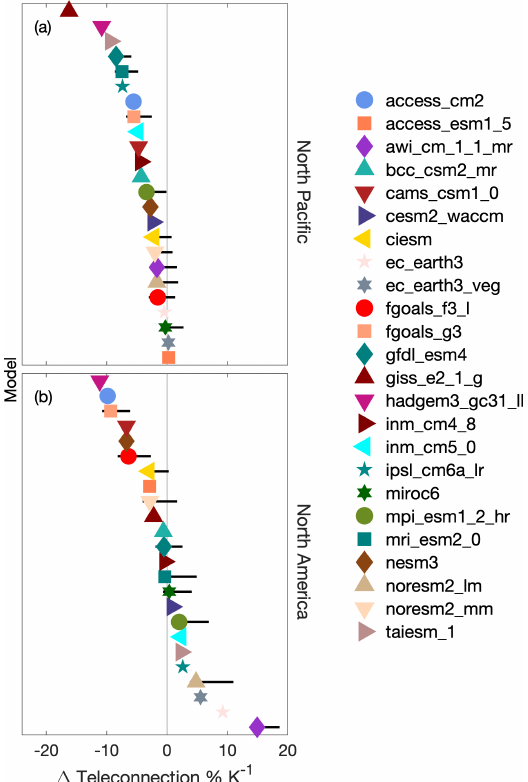
Figure 8. The total change to the MJO teleconnection over (a) the North Pacific and (b) North America due to the change in the full mean state (markers), and the potential range that results from con- sidering changes to MJO propagation and intensity characteristics (horizontal lines extending from each marker) for the 10 models for which we ran perturbed MJO